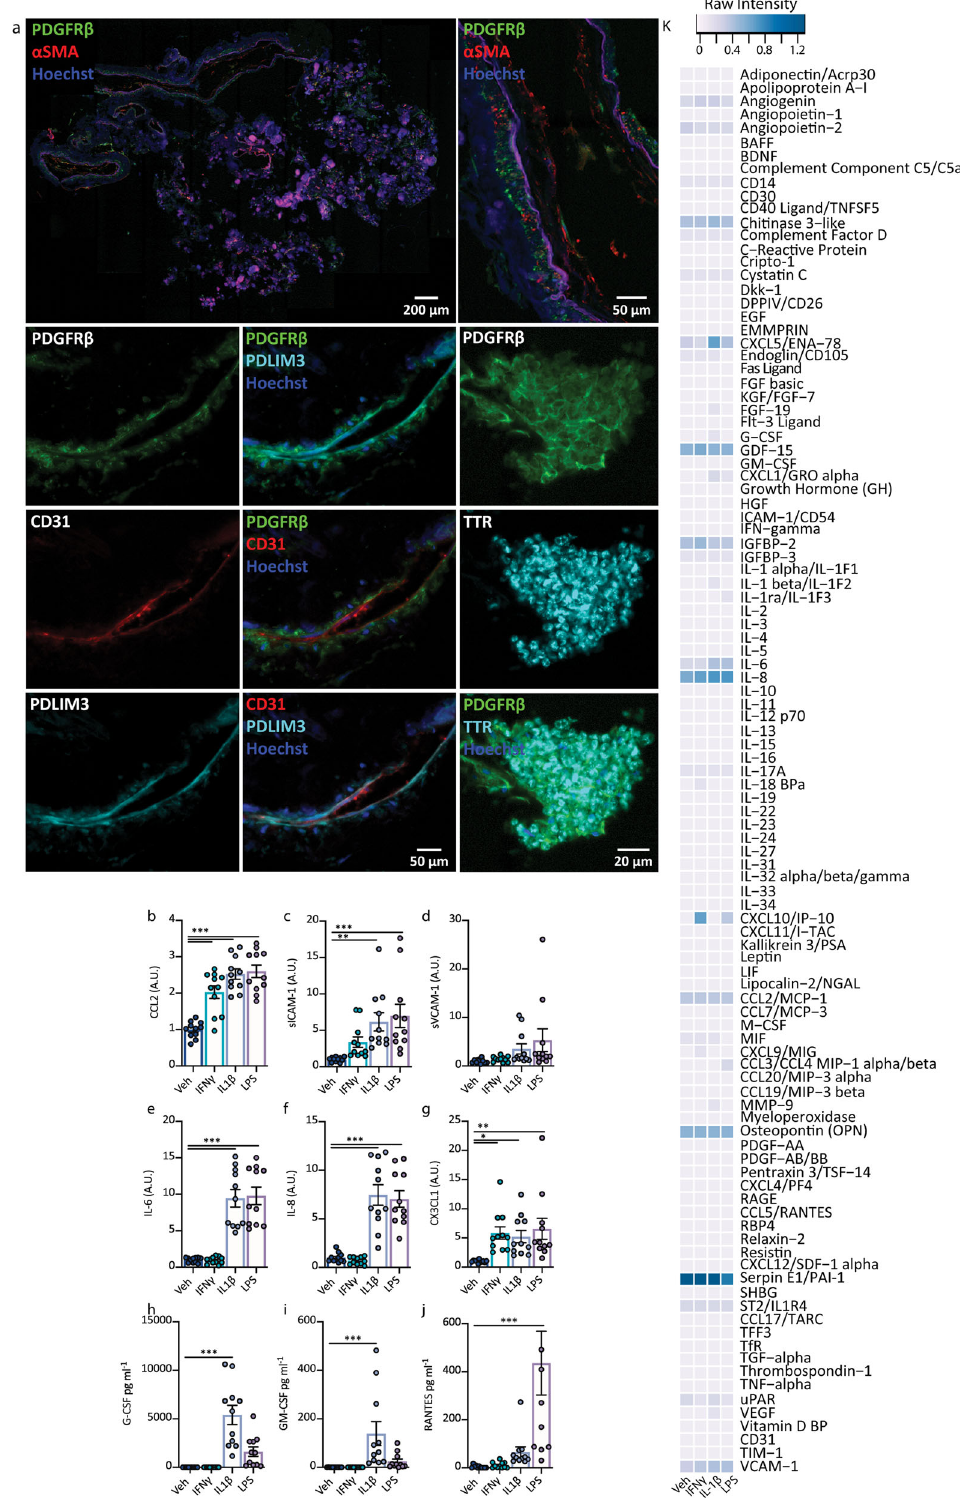
Fig. 7 Characterisation of choroid plexus explant cell types and in fl ammatory signature. a Immunohistochemical staining of CPE for vascular cells types including pericytes (PDGFR β ) endothelial cells (CD31), fi broblasts (PDLIM3), smooth muscle cells ( α SMA) and epithelial cells (transthyretin (TTR)). b – j Secretions from CPE following in fl ammatory stimulation with vehicle (white bars), IFN γ (blue bars), IL-1 β (cyan bars) or LPS (violet bars) were investigated using cytometric bead arrays ( n = 3 cases used: FTD6, HC166, AZ133, three explants per case), values normalised to vehicle condition, raw values Fig. S9. One way ANOVA, Dunnett ’ s multiple comparisons test, mean ± SEM.*** p < 0.001, ** p < 0.01, * p < 0.05. k Proteome pro fi lers were used to detect secretions from human brain choroid plexus explants (average of n = 2 cases used: FTD6, HC166, each pooled from threee explants per condition) after 24 h of in fl ammatory stimulation with vehicle, IFN γ , IL-1 β or LPS (10 ng mL − 1 ), raw intensities were normalised to reference spots.